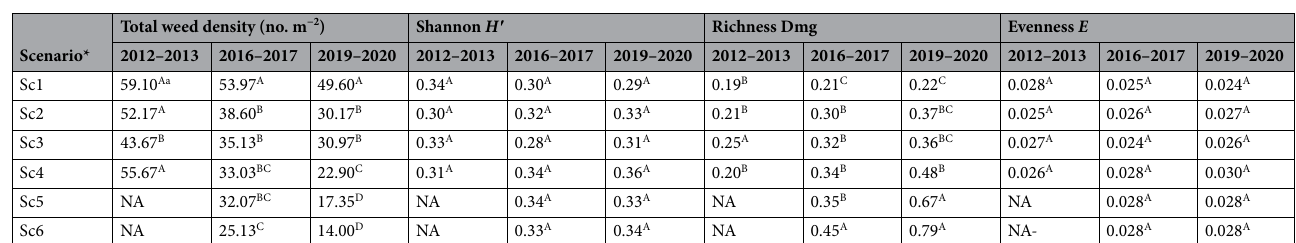
Table 2. Total weed density and diversity indices (Shannon, Richness and Evenness) under climate-smart agriculture-based management practices during the different years. * Refer Table 1 for scenario description. a Different capital letters indicate the means that are significantly different among treatments (least significant difference; P <